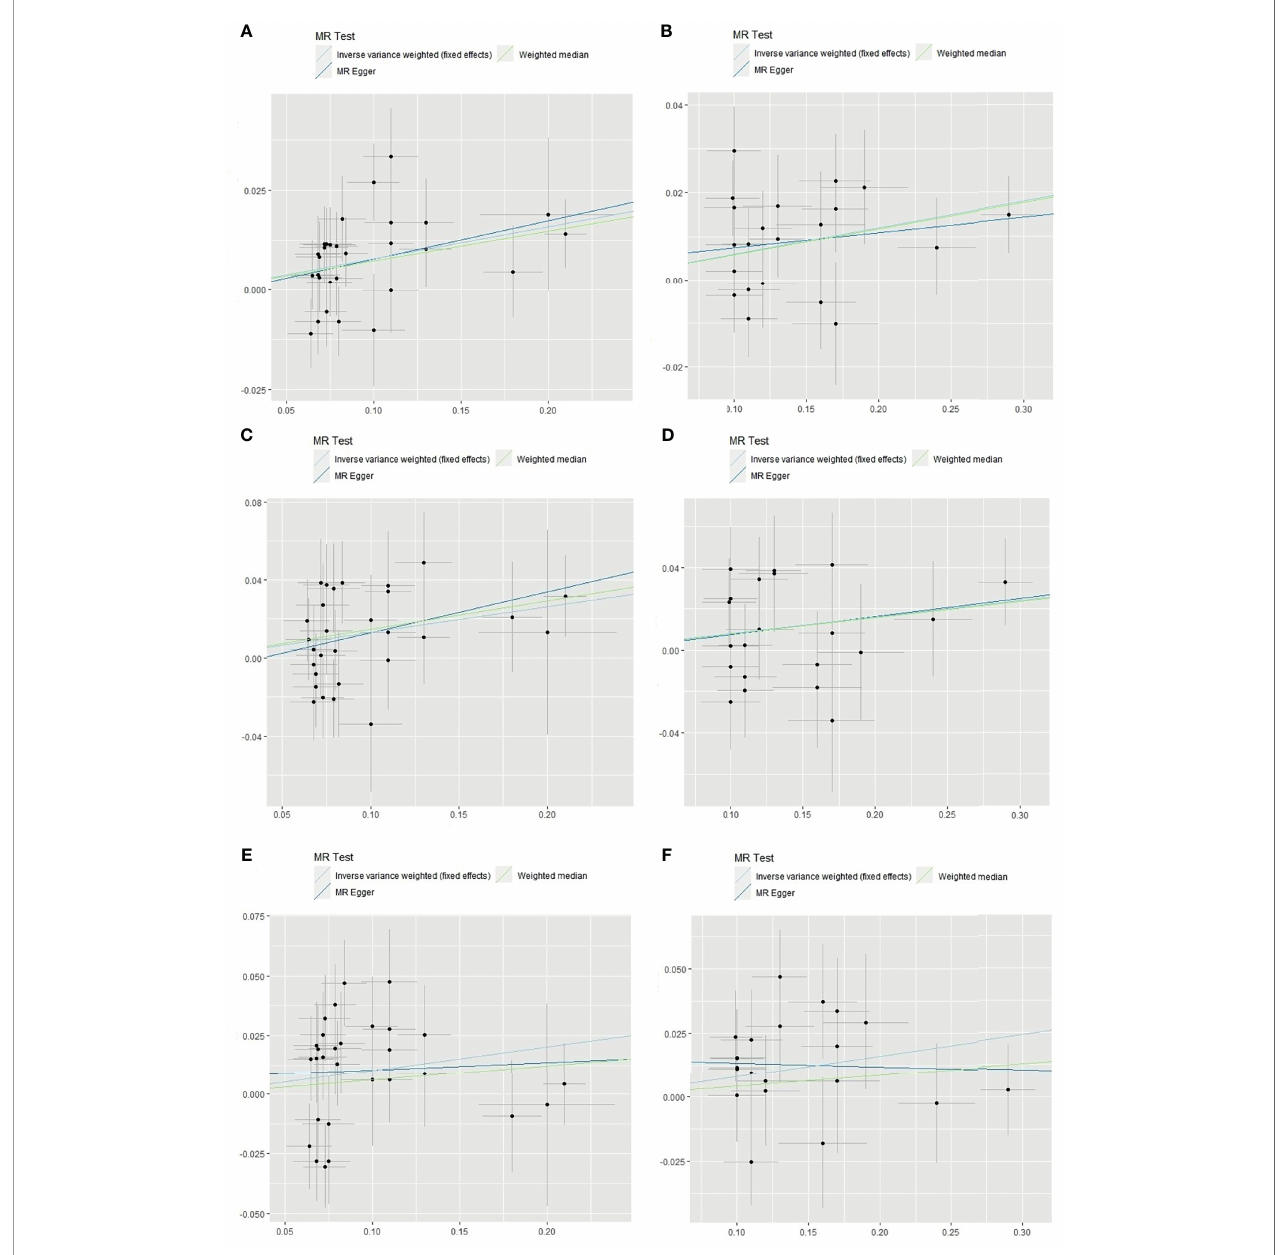
FIGURE 3 | The scatter plot of obesity classes I and II with the risk of IS, LAS, and CES in the MR analysis. (A) Analysis of obesity class I and risk of IS. (B) Analysis of obesity class II and risk of IS. (C) Analysis of obesity class I and risk of LAS. (D) Analysis of obesity class II and risk of LAS. (E) Analysis of obesity class I and risk of CES. (F) Analysis of obesity class II and risk of CES. IS, ischemic stroke; LAS, large artery stroke; CES, cardioembolic stroke; MR, Mendelian